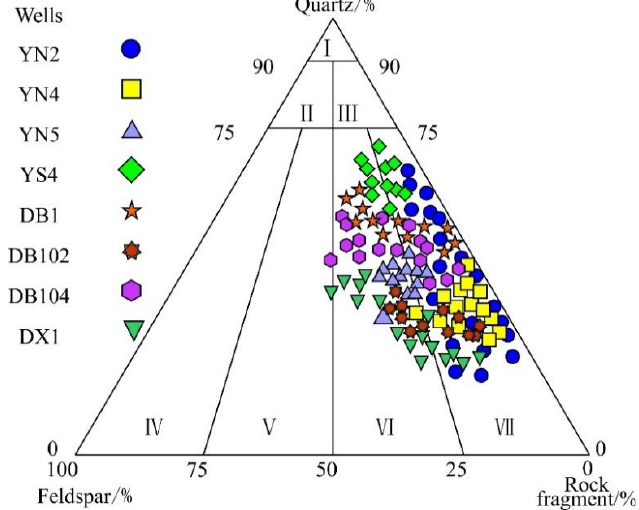
Figure 3. Figure indicating the composition of J 1 a tight sandstone from Dibei gas field, eastern Kuqa Depression (number of samples = 105). Note: I — quartz sandstone; II — feldspar quartz sandstone; III — lithic quartz sandstone; IV — arkose sandstone; V — lithic arkose; VI — feldspar lithic sandstone; VII — lithic sandstone.